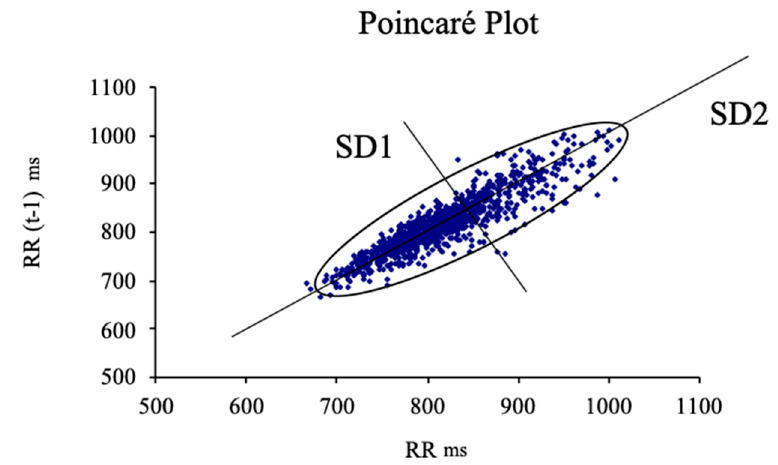
Figure 3. Model of Pointcaré plot.